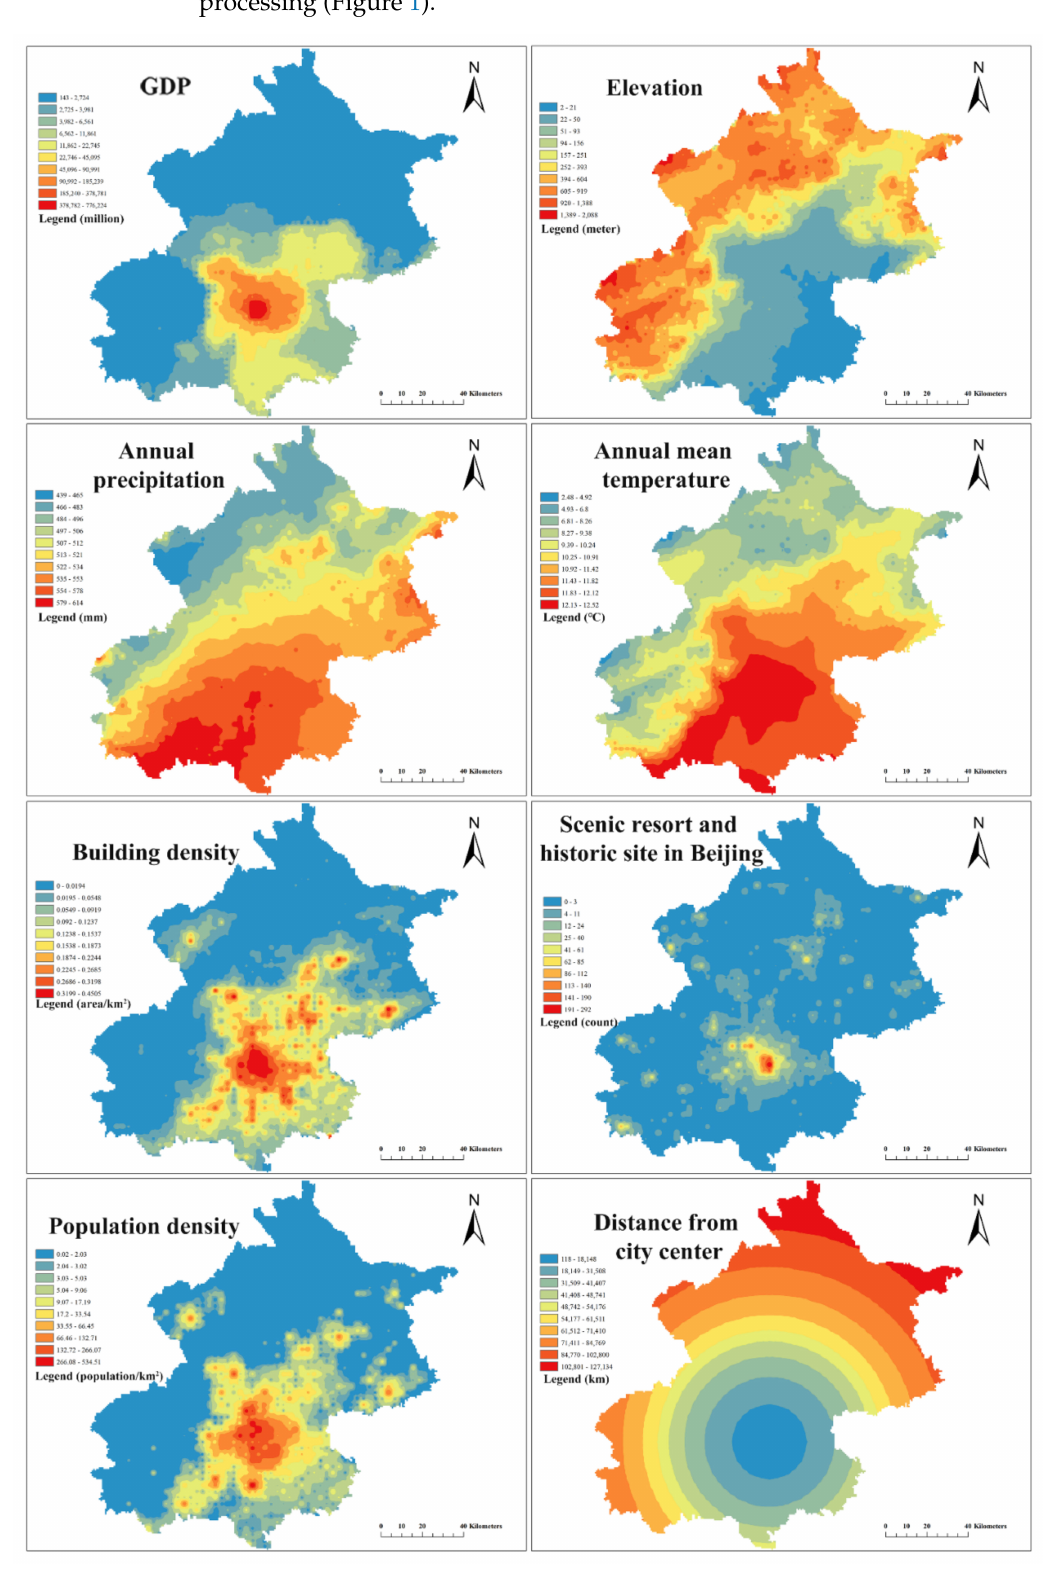
Figure 1. Eight explanatory